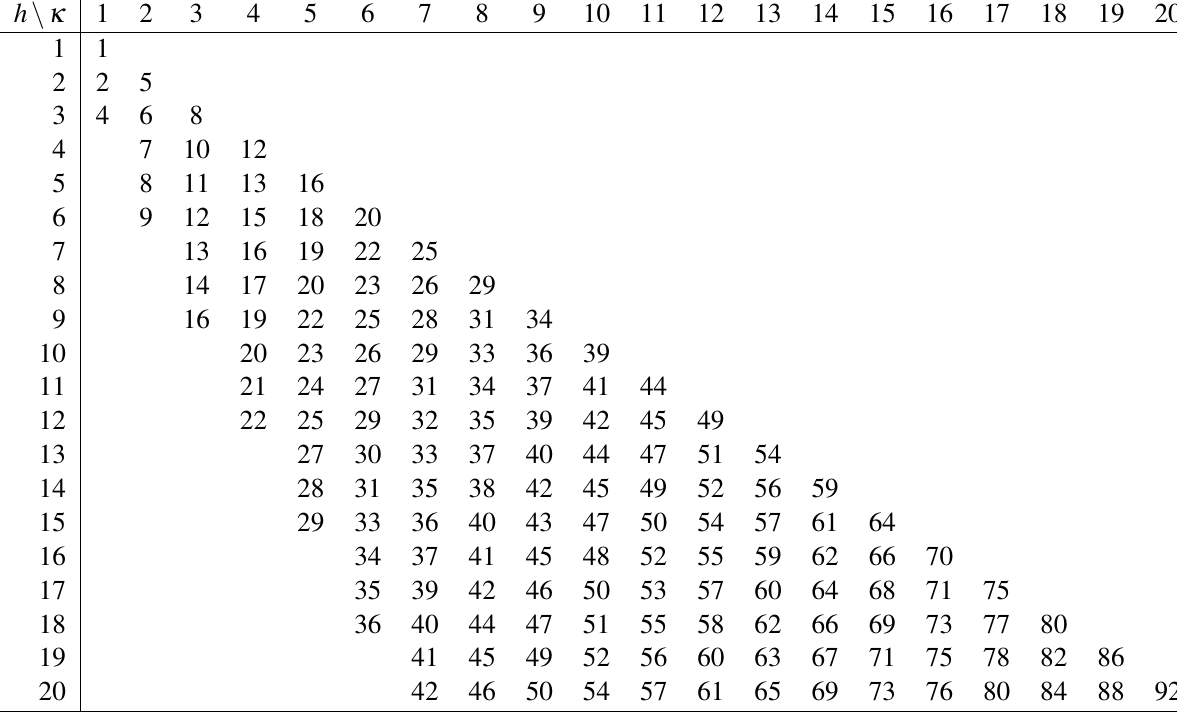
Table 1: Admissible values of r for h (cid:54)